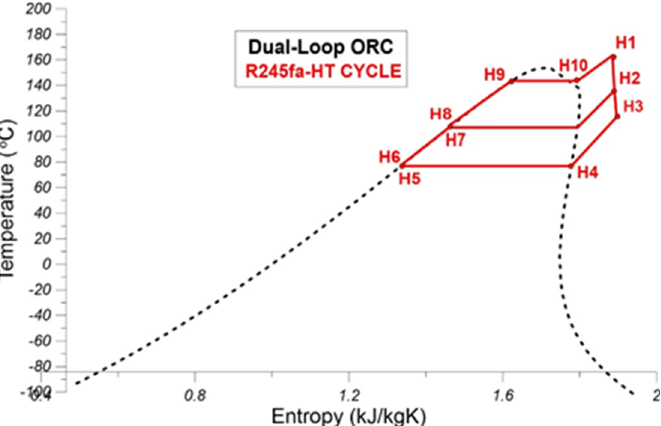
Figure 2. Representation of thermodynamic processes of the high temperature (HT) loop of the regenerative dual-loop ORC with OFOH in a T-s diagram.